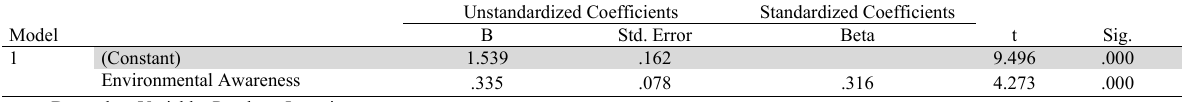
Simple Regression Analysis Between Awareness and Intention Model